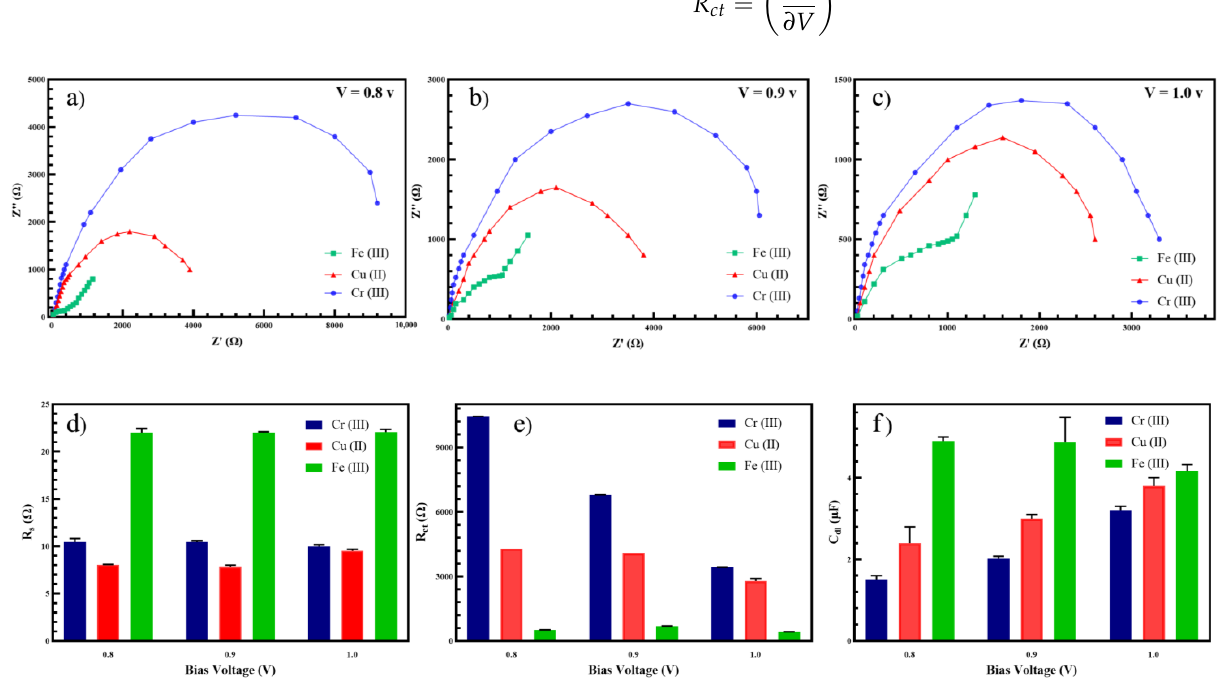
Figure 3. The Nyquist spectra of electro-synthesized PAni in the electrolyte at ( a ) 0.8 V, ( b ) 0.9 V, and ( c ) 1.0 V. The values of ( d ) resistance of solution, ( e ) charge transfer resistance, and ( f ) double layer capacitance for the corresponding equivalent circuit.